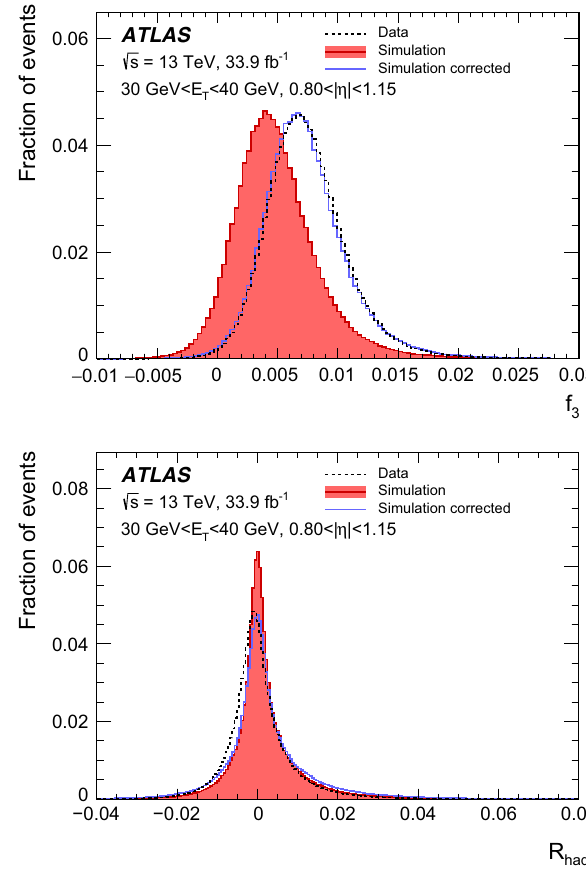
Fig. 6 Examplesofdistributionsoftwoquantities R φ (top)and f 1 (bot- tom), both defined in Table 1 and shown for 20 GeV < E T < 30 GeV and 0 . 6 < | η | < 0 . 8, that would be inefficient if used in a cut-based identification, but which, nonetheless, have significant discriminating power against background and, therefore, can be used to improve a LH-based identification. In each figure, the red-dashed distribution is determined from a background simulation sample and the black-line distribution is determined from a Z → ee simulation sample. These distributions are for reconstructed electron candidates before applying any identification. They are smoothed using an adaptive KDE and have been corrected for offsets or differences in widths between the distri- butions in data and simulation as described in Sect. 6.2